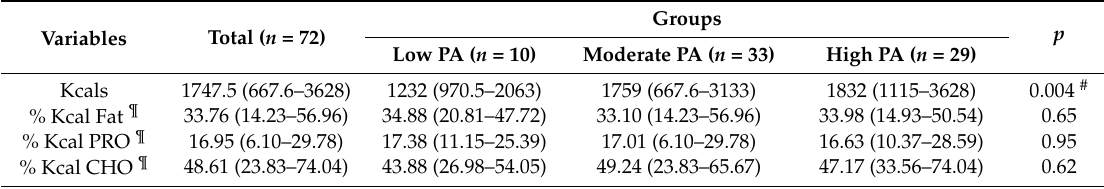
Table 3. Three-day average total caloric intake and percentages of total caloric intake at different physical activity